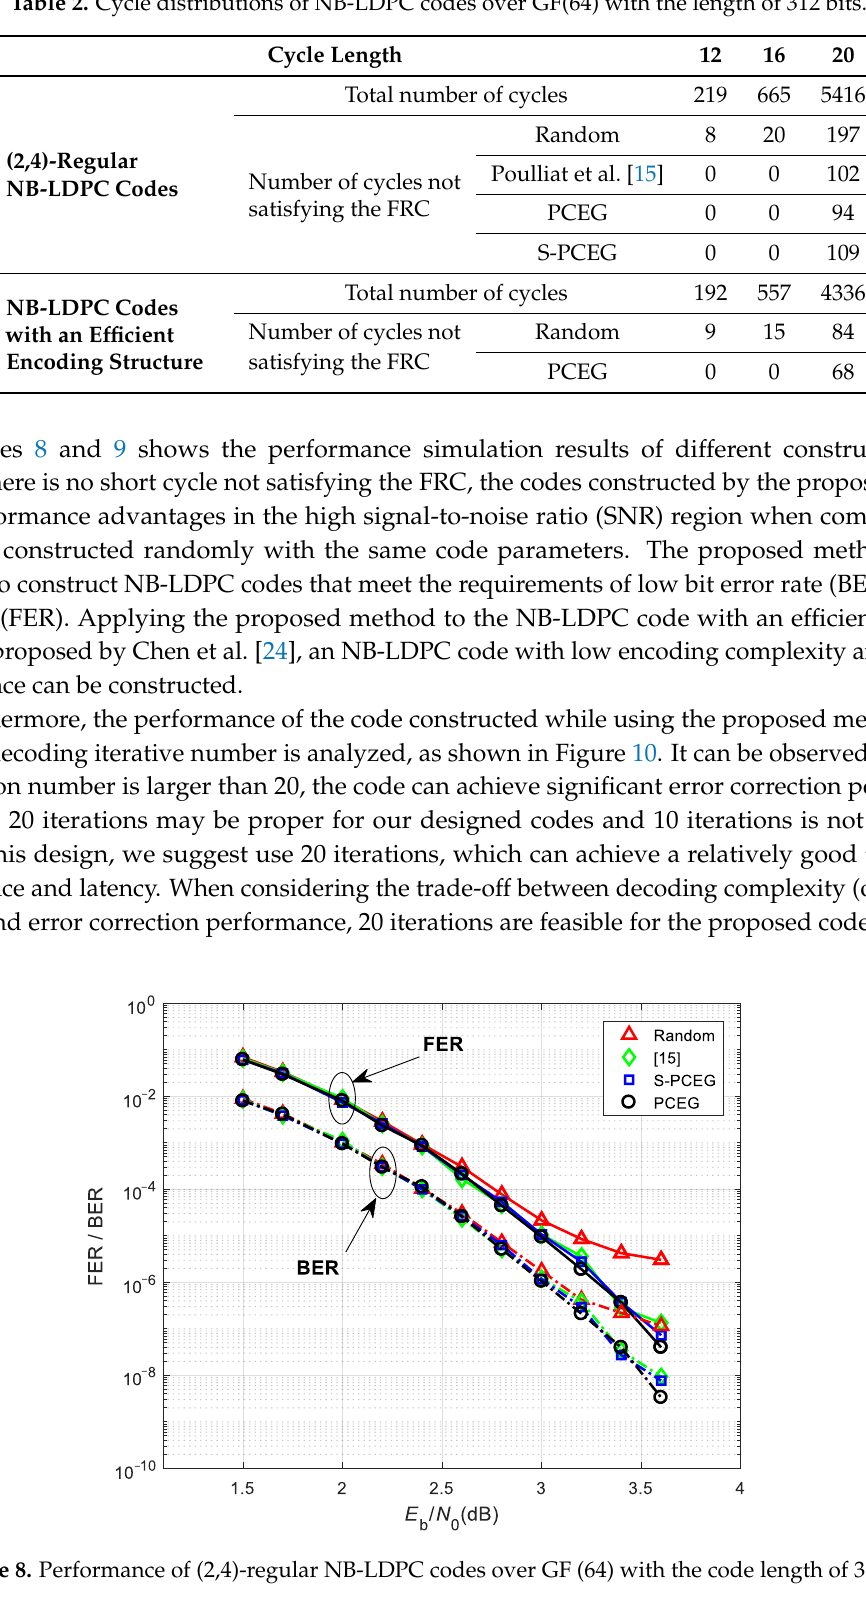
Table 2. Cycle distributions of NB-LDPC codes over GF(64) with the length of 312 bits.